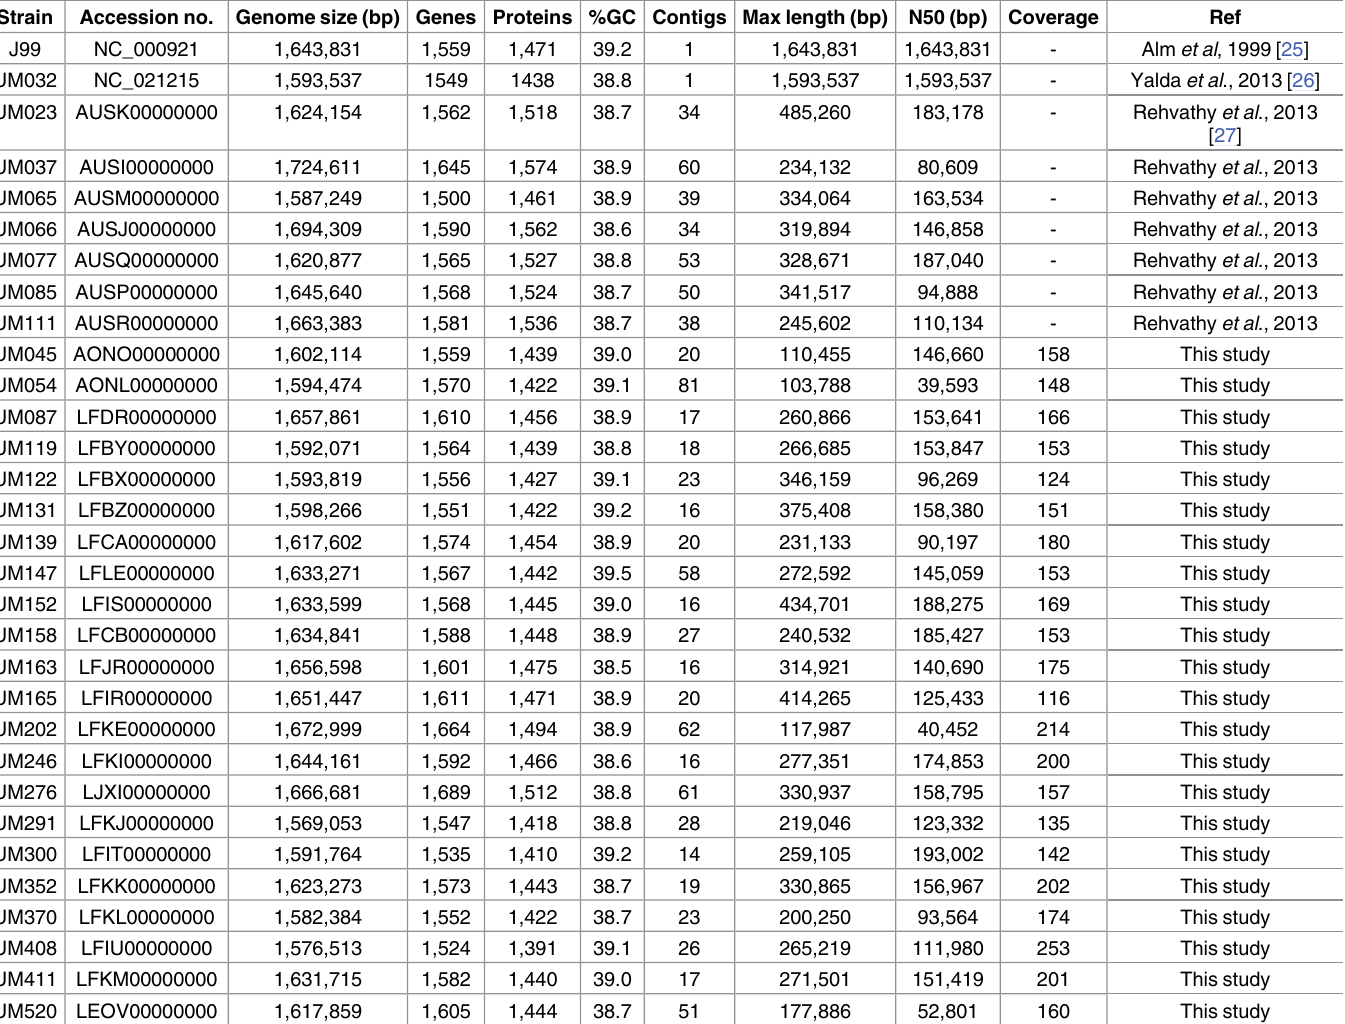
Table 1. Accession numbers and details of H . pylori genomic sequences used in this study.